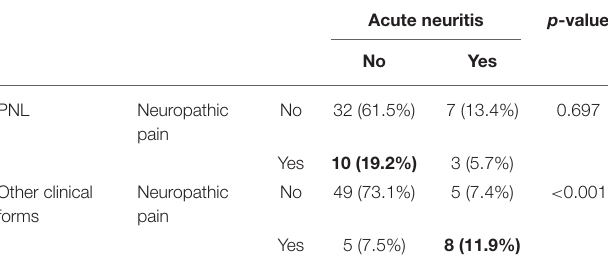
TABLE 3 | Number of patients with pure neural leprosy and other clinical forms of leprosy that developed acute neuritis during the evaluation period and number of patients that developed neuropathic